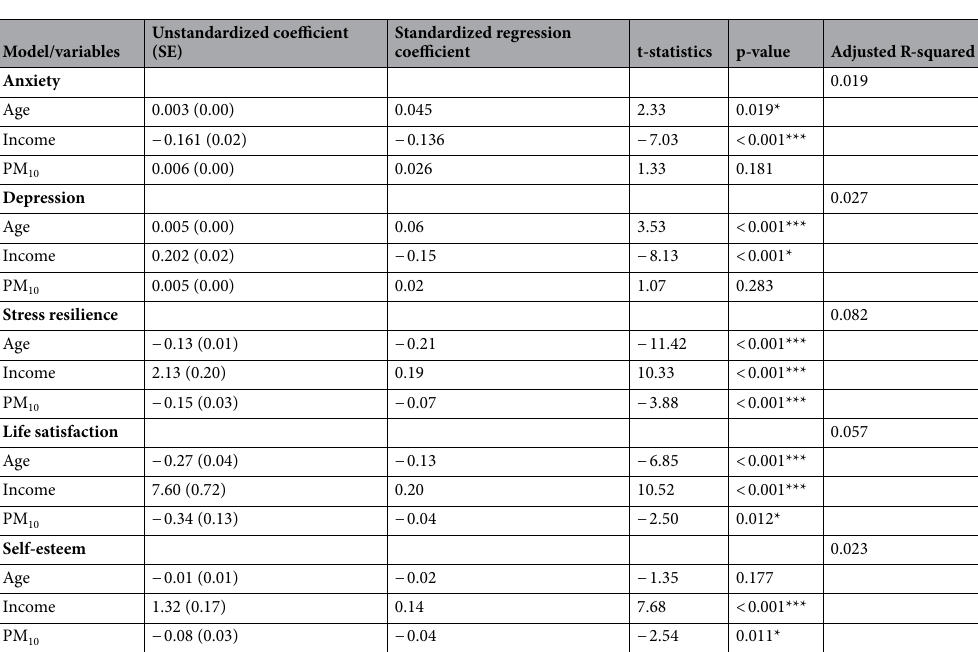
Table 2. Regression analyses predicting mental health and well-being determinants. Dependent variables anxiety, depression, stress resilience, life satisfaction and self-esteem. PM 10 particulate matter 10 µg/m 3 , SE standard error. *p < 0.05, ** p < 0.01, *** p < 0.001.